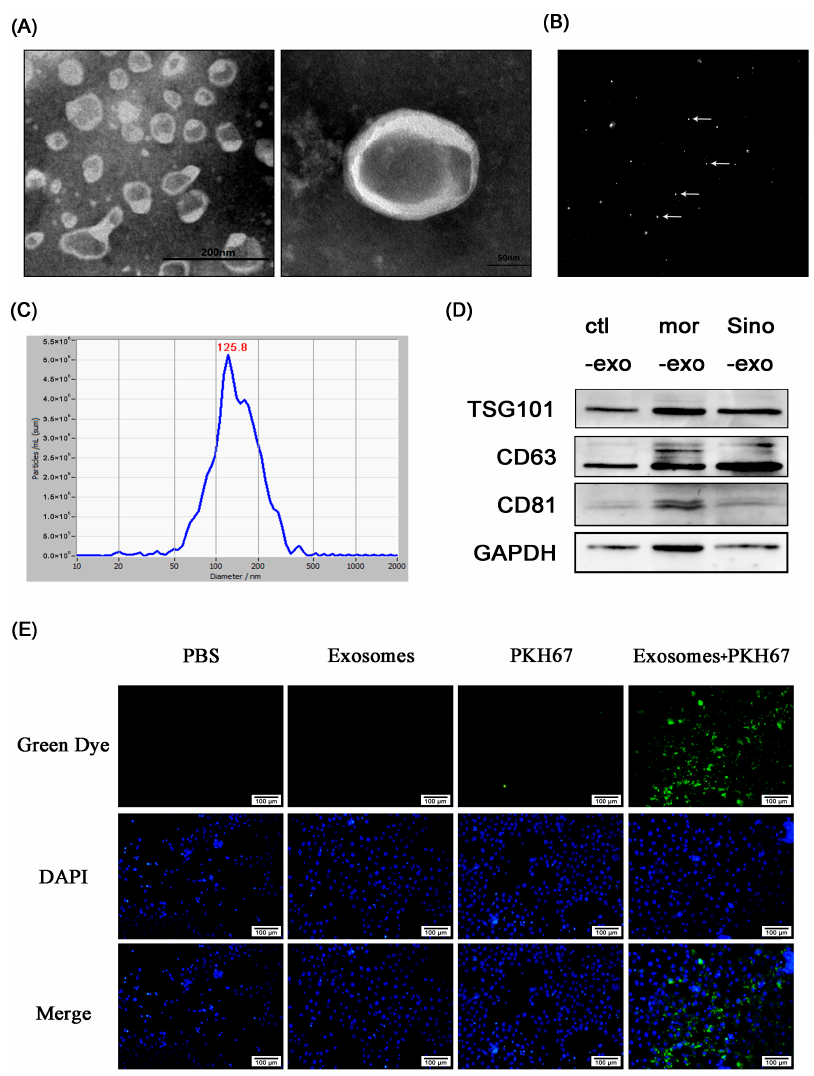
Figure 5. Astrocyte-derived exosomes can be taken up by neuronal SH-SY5Y cells. ( A ) Exosomes observed by transmission electron microscope; ( B , C ) Nanoparticle tracking analysis of exosomes; ( B ) The signal of scattered light by dynamic nanoparticles; the bright white dot indicates one moving particle; ( C ) Particle size distribution of nanoparticles; ( D ) Western blotting was used to detect TSG101, CD63, andCD81 proteins of exosomes. Ctl-exo: exosomes extracted from cultured primary astrocytes; mor-exo: exosomes extracted from cultured primary astrocytes treated with 100 μ M morphine for 48 h; Sino-exo: exosomes extracted from cultured primary astrocytes treated with 100 μ M morphine and 200 μ Msinomenine for 48 h; ( E ) Astrocyte-derived exosomes were labeled by PKH67 and were taken up by neuronal SH-SY5Y cells.